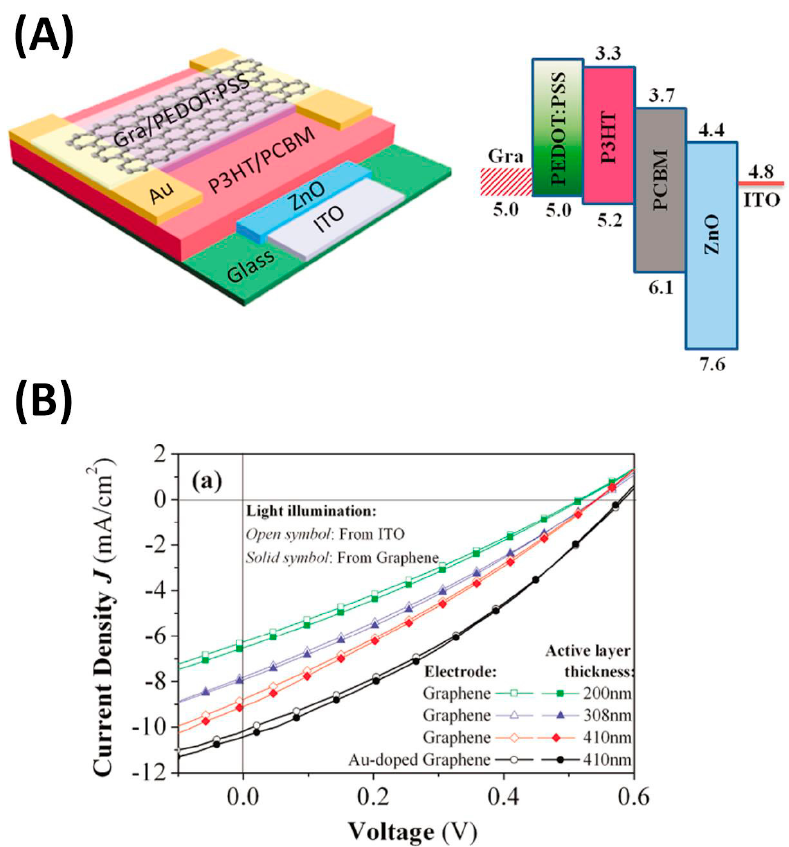
Figure 3. ( A ) Schematic representation and band structure of a PSC with the structure glass/indium tin oxide (ITO)/ZnO/P3HT:PCBM/Au/PEDOT:PSS/G; ( B ) J–V characteristics measured from two sides of the PSC with G top electrode and different active layer thicknesses. Reproduced with permission from Ref. [53].